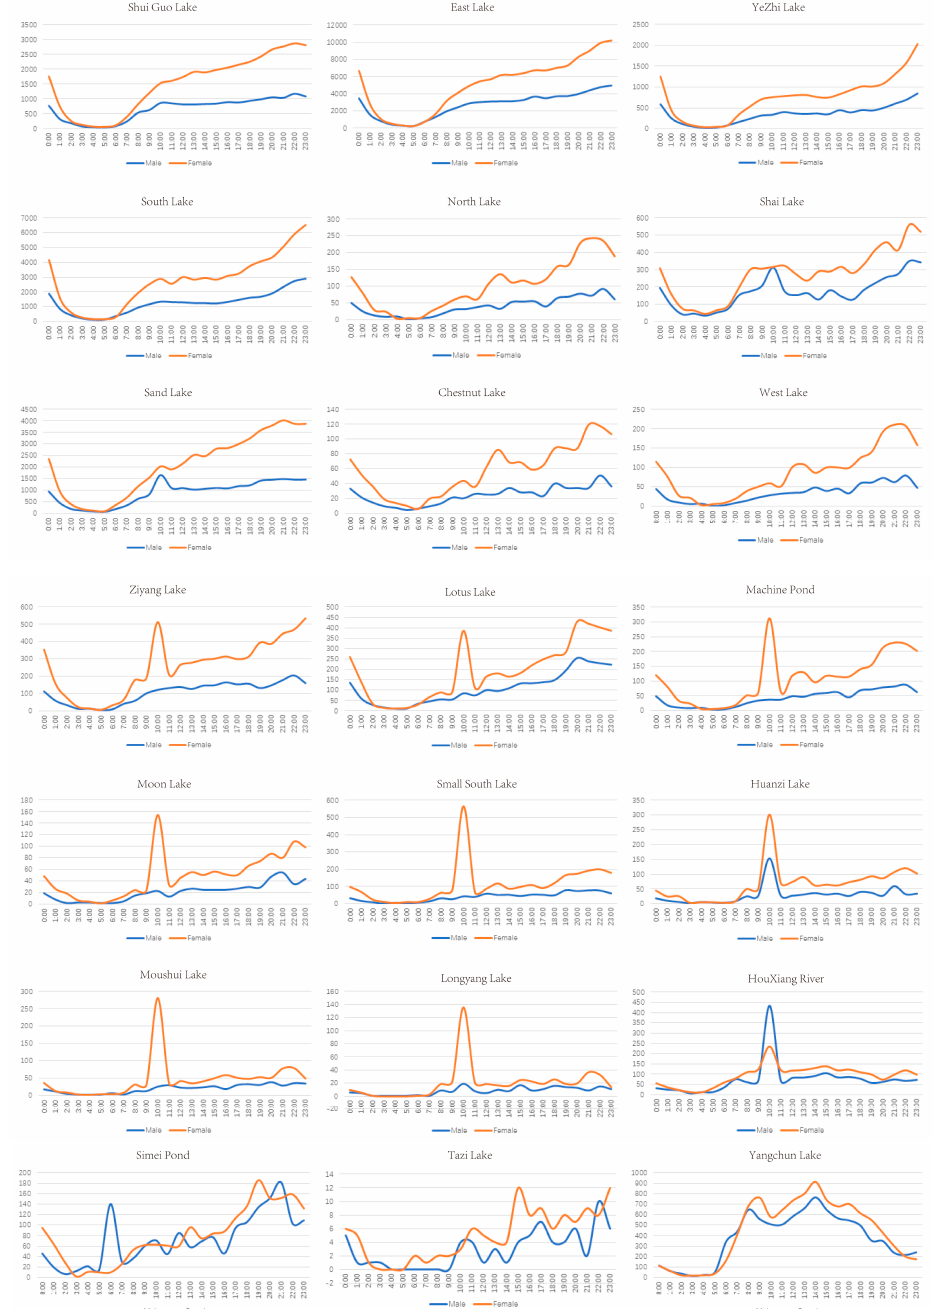
Figure 8. Changing trend of the check-in numbers of different genders in 21 major lakes in Wuhan in one day.